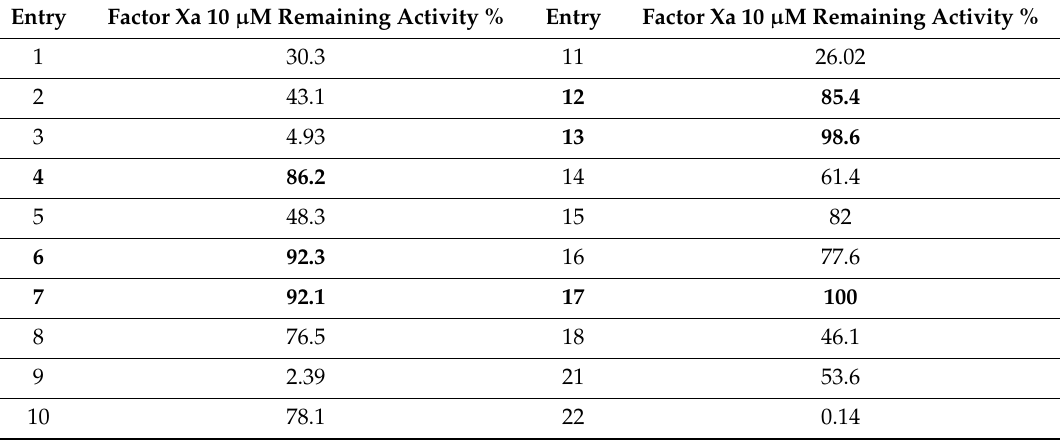
Table 6. Factor Xa inhibition of the 20 C1s inhibitor hit compounds. (Compounds with remaining activities > 80 % are shown in